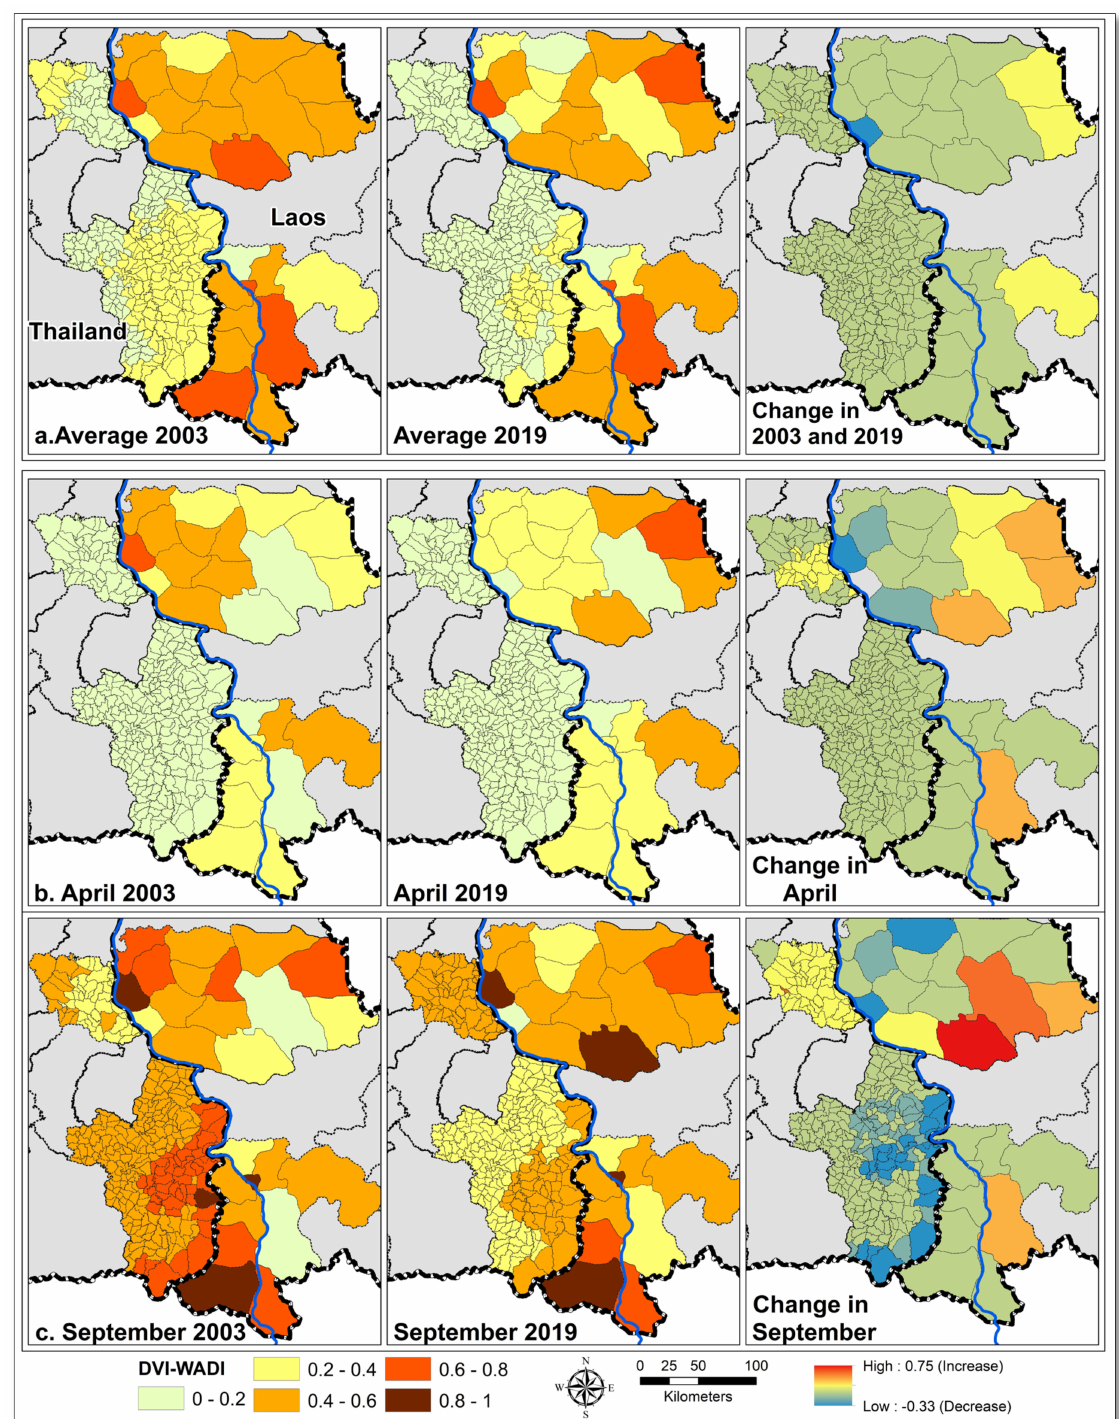
Figure 7. Dengue Vulnerability Index–Water Associated Disease Index (DVI WADI ). ( a ) The upper panels show average DVI WADI in 2003 (left), 2019 (middle), and change between 2003 and 2019 (right). ( b ) The middle panels show DVI WADI in April 2003 (left), April 2019 (middle), and change between April 2003 and April 2019 (right). ( c ) The lower panels show DVI WADI in September 2003 (left), September 2019 (middle), and change between September 2003 and September 2019 (right). DVI WADI 0 = lowest and 1 =